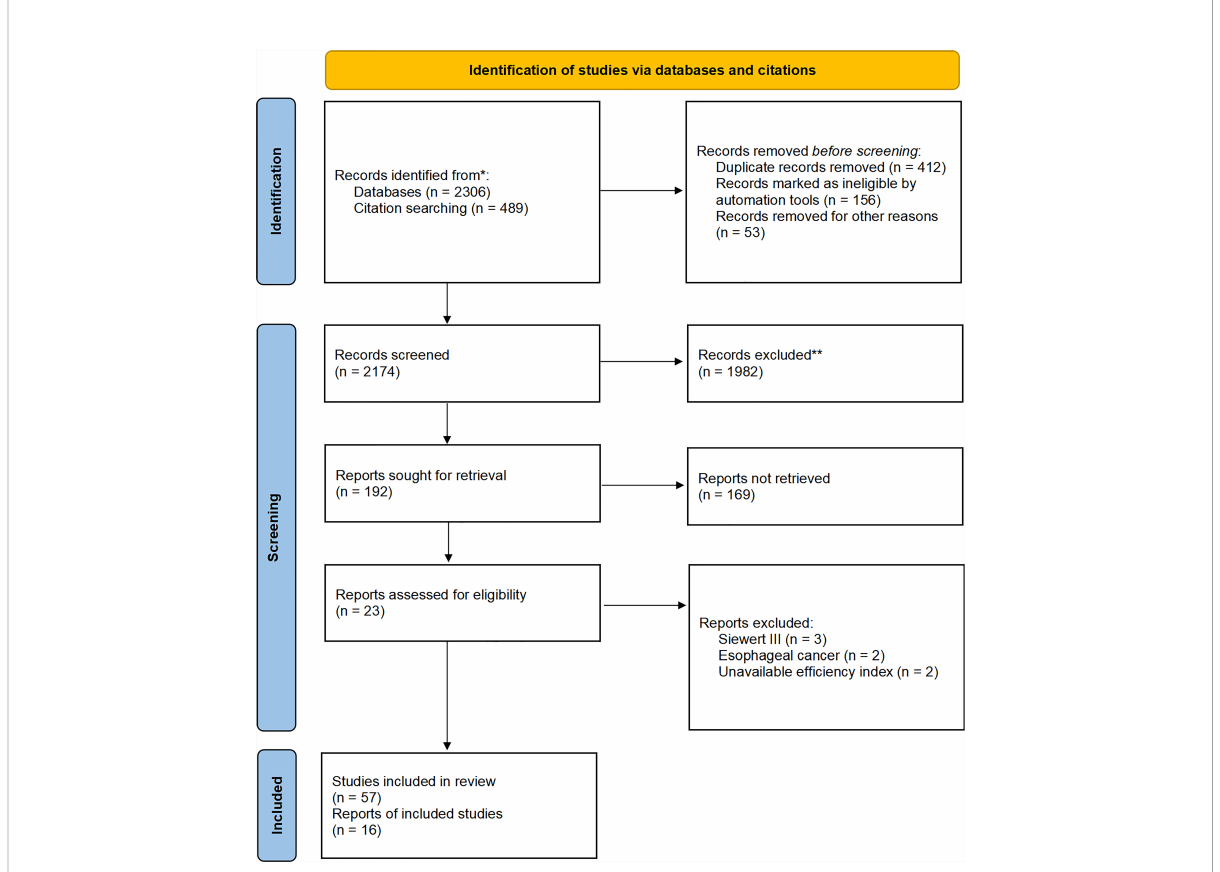
FIGURE 3 Flow diagram of included studies. From: Page MJ, McKenzie JE, Bossuyt PM, Boutron I, Hoffmann TC, Mulrow CD, et al. The PRISMA 2020 statement: an updated guideline for reporting systematic reviews. BMJ 2021;372:n71. doi: